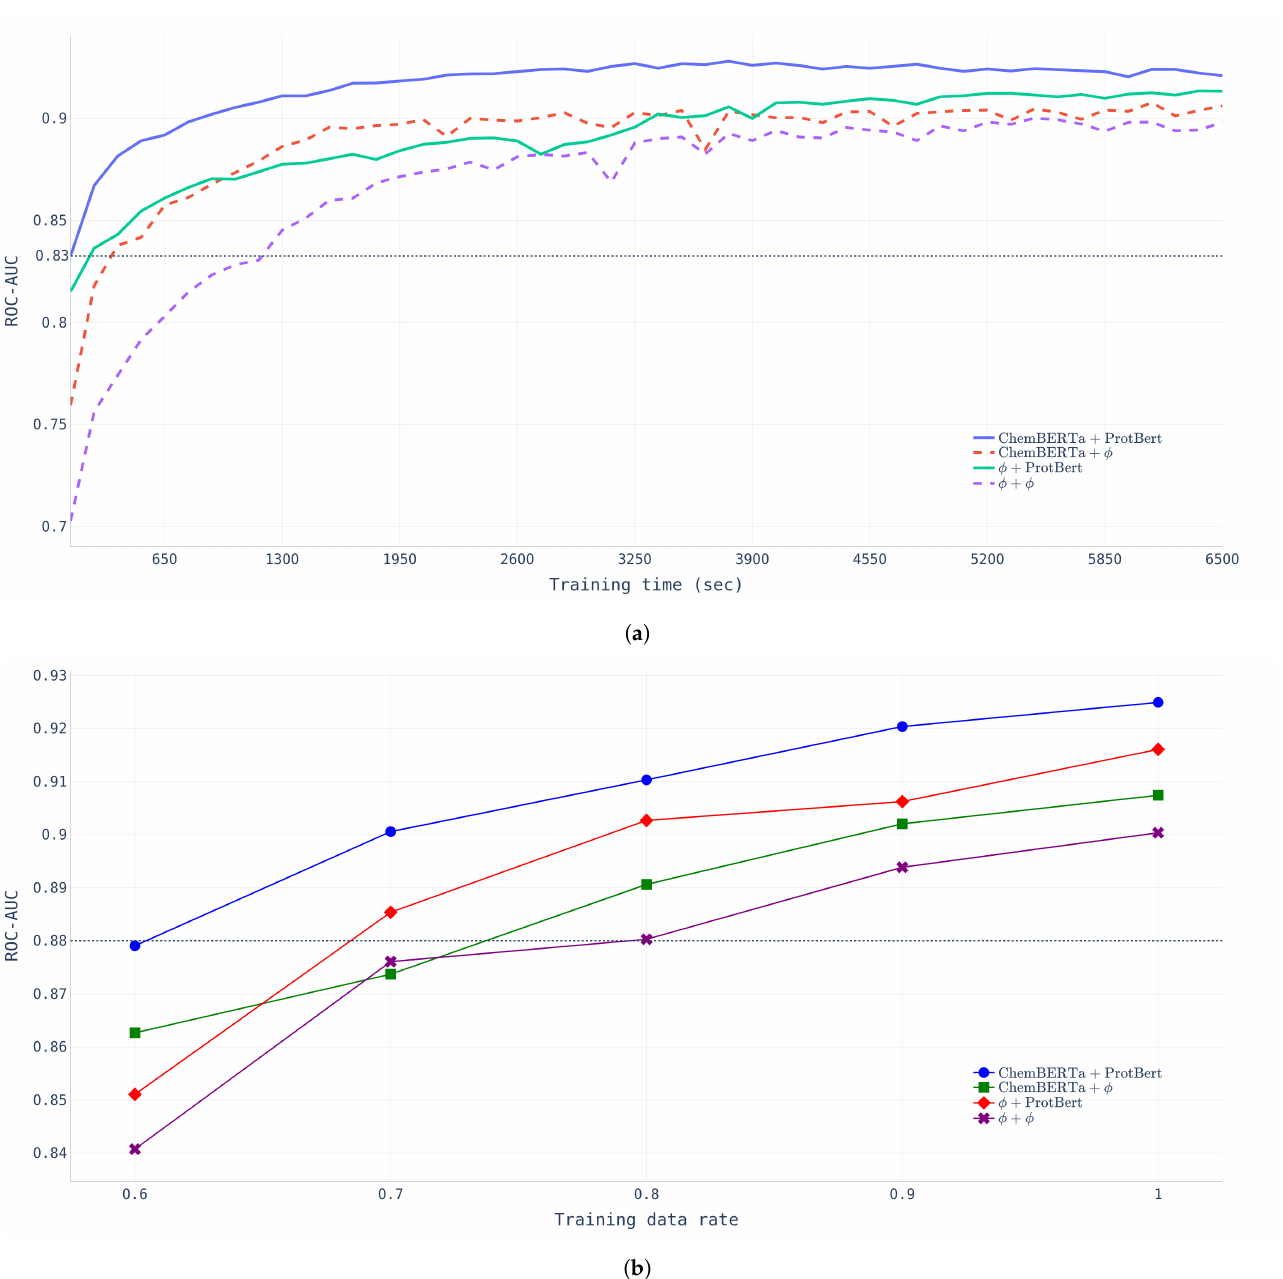
Figure 4. Pretraining effects with BindingDB data with four different models. ( a ) Learning time effect of pretraining. ( b ) Data-size effects of